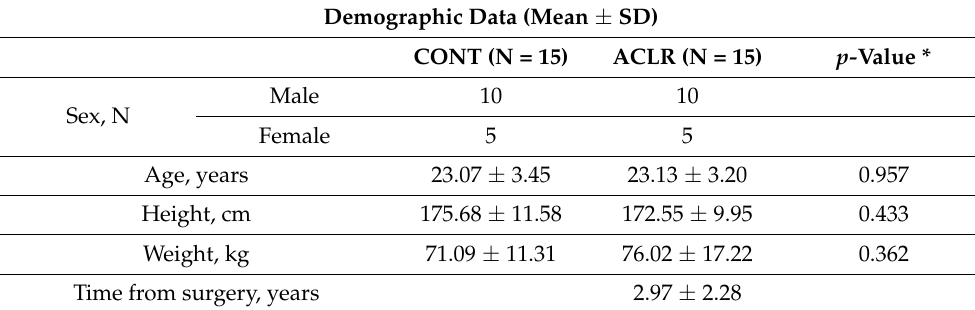
Table 1. Participant demographic